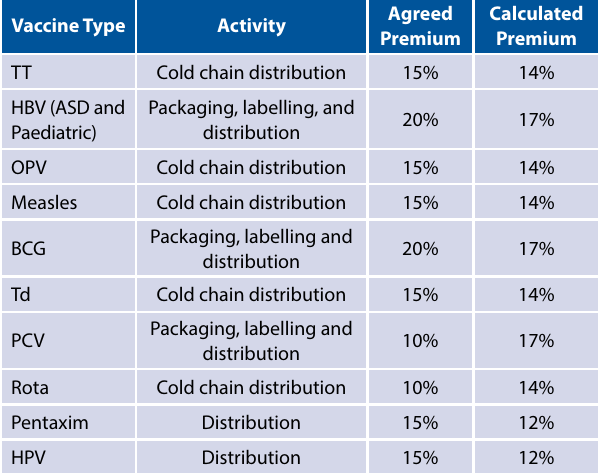
Table 5. Premiums charged and activity per vaccine Vaccine